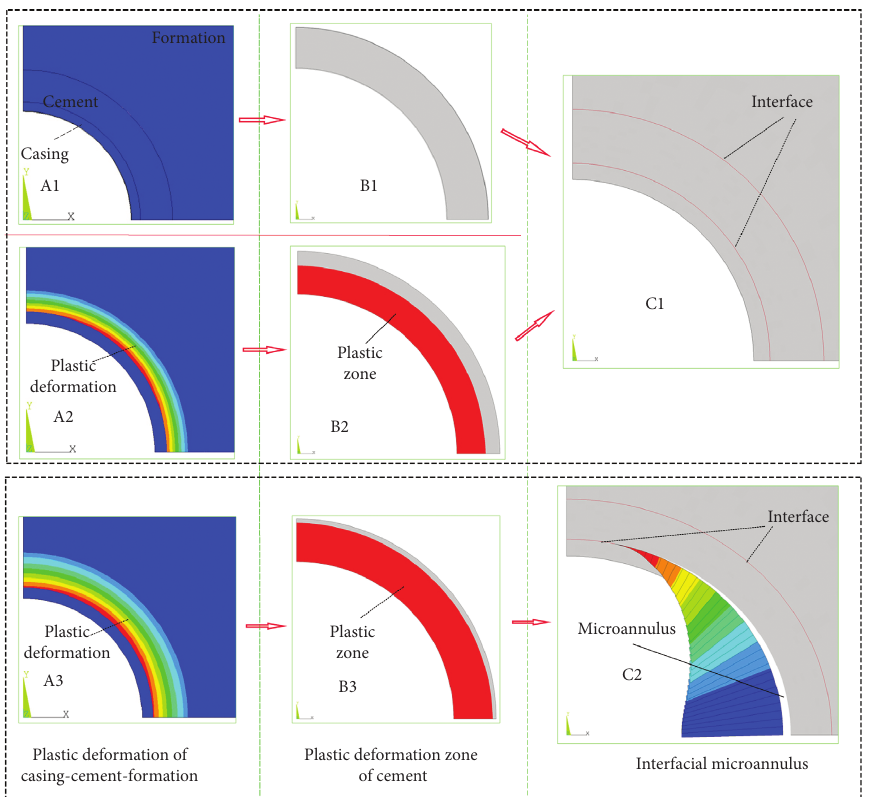
Figure 8: Microannulus caused by elastic-plastic deformation of cement.